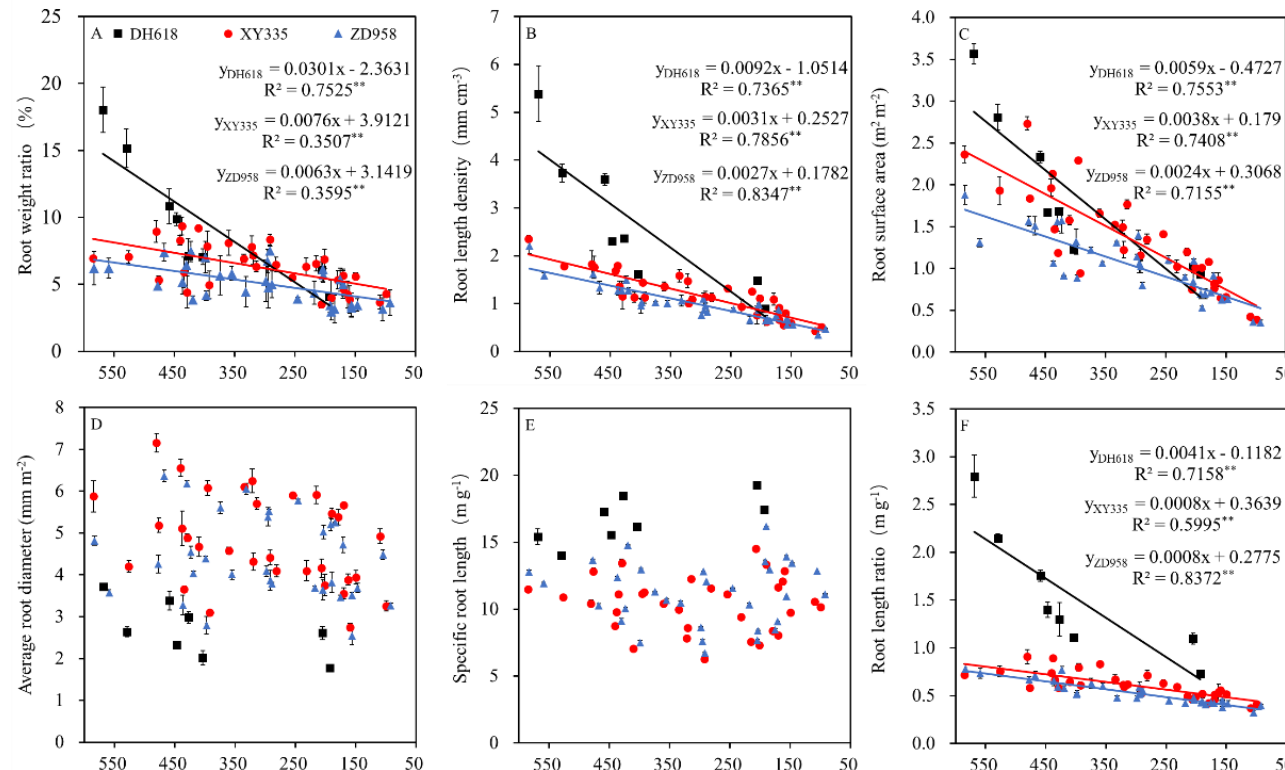
Figure 11. Quantitative relationships between TIPAR and root weight ratio (RWR, %) ( A ), root length density (RLD, mm cm −3 ) ( B ), root surface area (RSA, m 2 m −2 ) ( C ), average root diameter (ARD, mm m −2 ) ( D ), specific root length (SRL, m g −1 ) ( E ) and root length ratio (RLR, m g −1 ) ( F ). The bars represented the error standard ( n = 24). ** significant differences at p < 0.05 and p < 0.01, respectively.